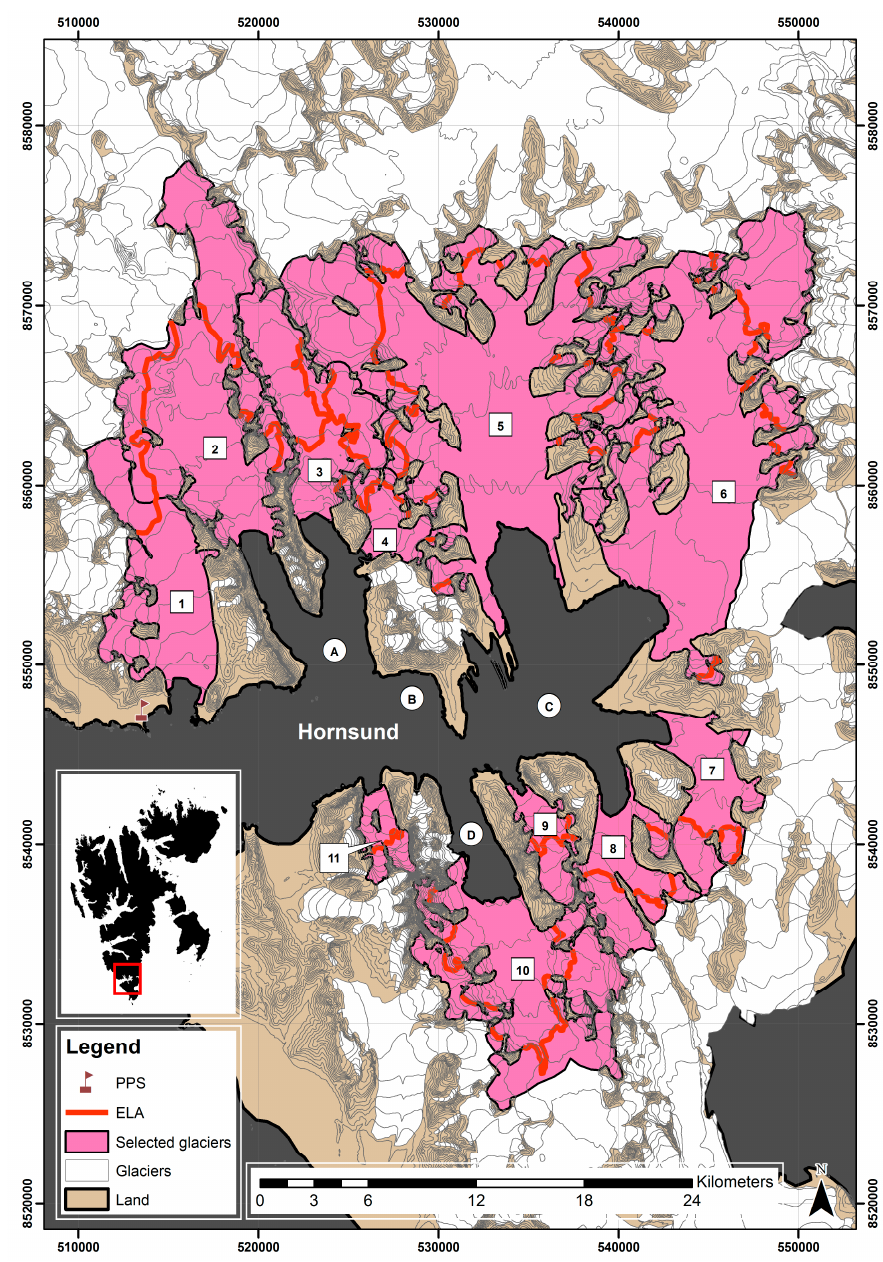
Figure 1. Study area: (PPS) Polish Polar Station Hornsund; (ELA) Equilibrium-Line Altitude in 2014; selected glaciers: (1) Hansbreen; (2) Paierlbreen; (3) Mühlbacherbreen; (4) Kvalfangarbreen; (5) Storbreen; (6) Hornbreen; (7) Svalisbreen; (8) Mendelejevbreen; (9) Chomjakovbreen; (10) Samarinbreen; (11) Körberbreen; selected bays: (A) Burgerbukta; (B) Adriabukta; (C) Brepollen; (D) Samarinvågen. The 50 m contour lines are based on the Digital Terrain Model (2014) published by the Norwegian Polar Institute. The glacier basin boundaries follow [8] with reshaped glacier termini from the end of melting period in 2014.